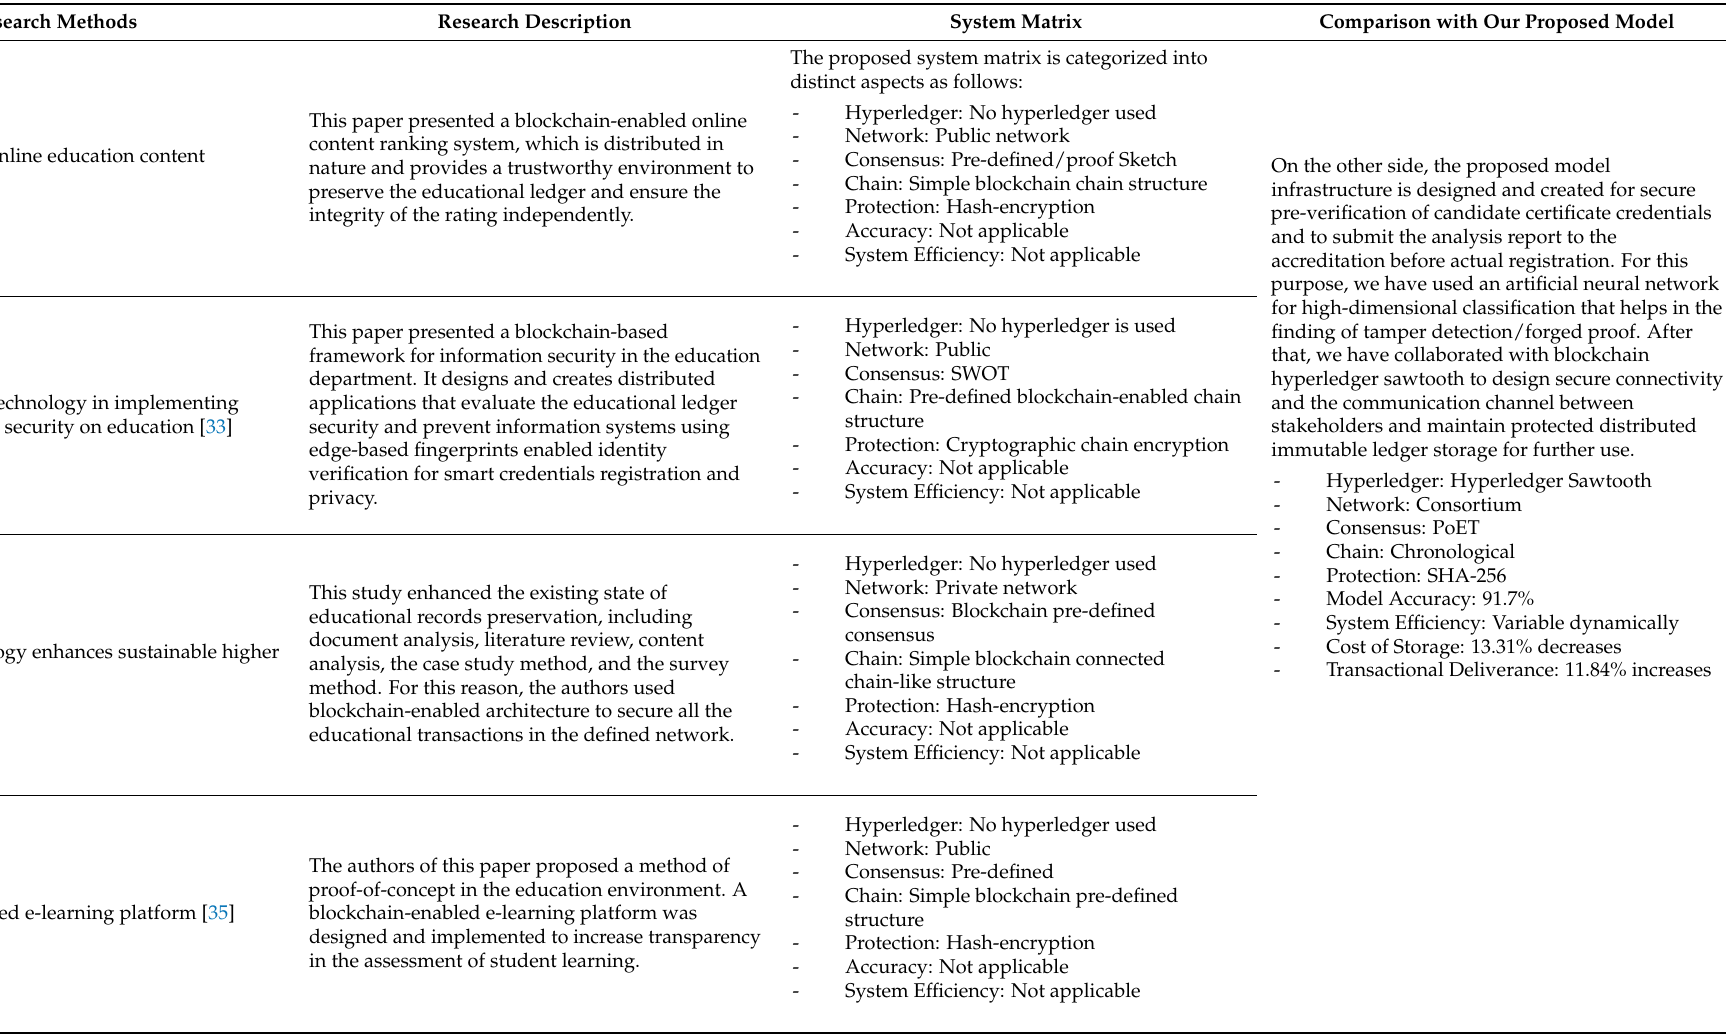
Table 2. Comparison